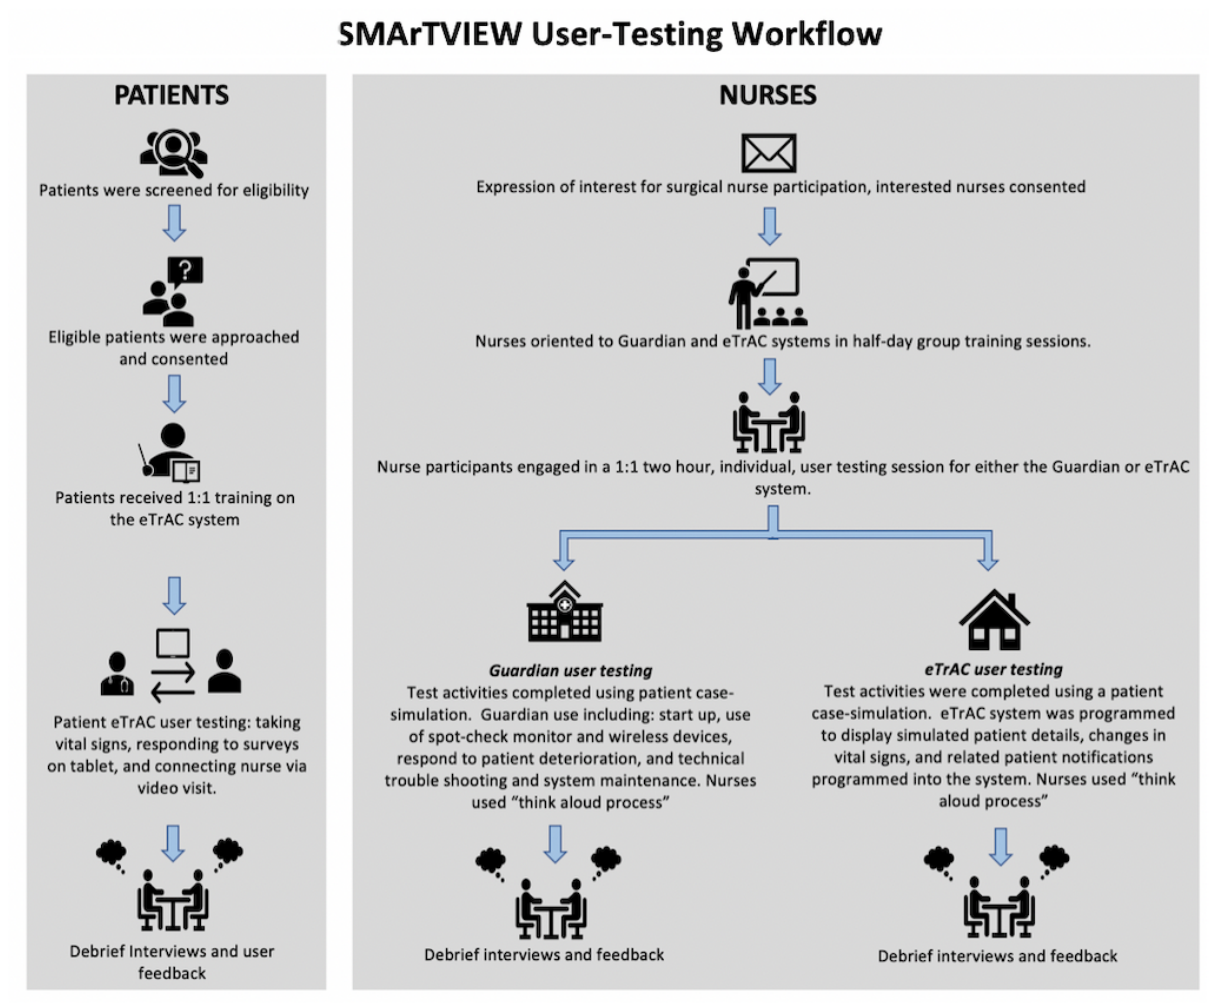
Figure 3. Nurse and patient user testing workflow